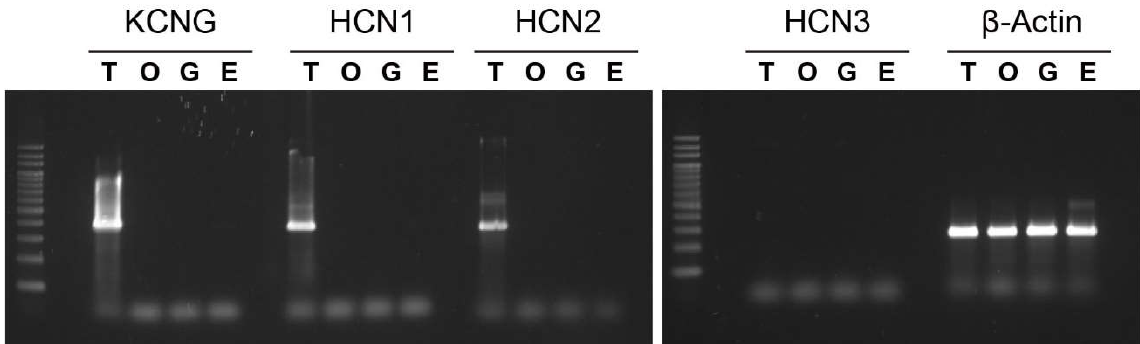
Figure 4. Tissue expression patterns of the CNG genes in Ciona tissues. RT-PCR analysis of mRNA from several adult Ciona tissues shows that the expression of KCNG, HCN1 and 2 is testis-specific. β -Actin was used as an internal control. E, endostyle; G, gill; T, testis; O, ovary.